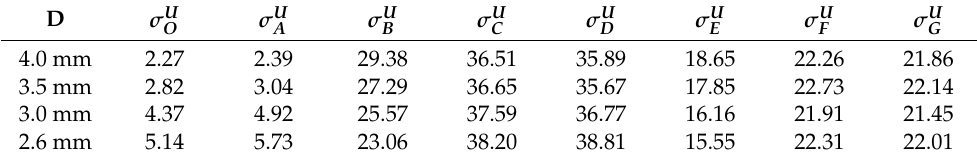
Table 3. Stress at different positions of triaxial geogrid after longitudinal stretching. (MPa).